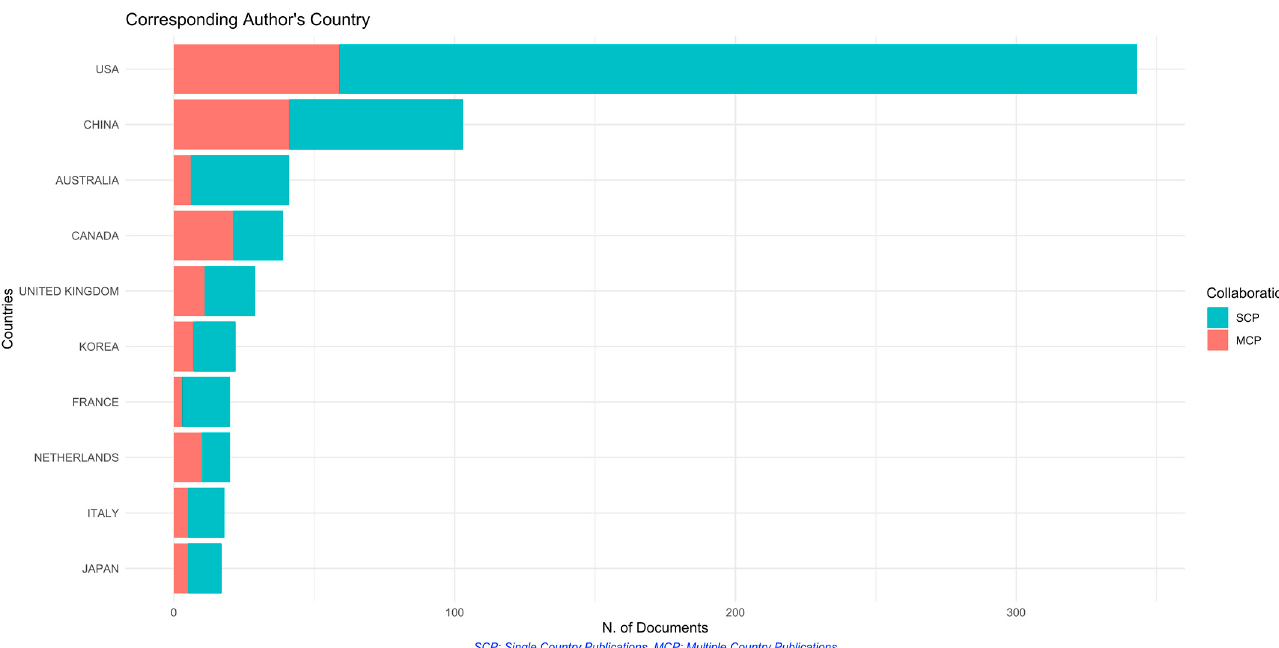
Figure 4. Top countries publishing on environmental toxicants and pollutants and preterm